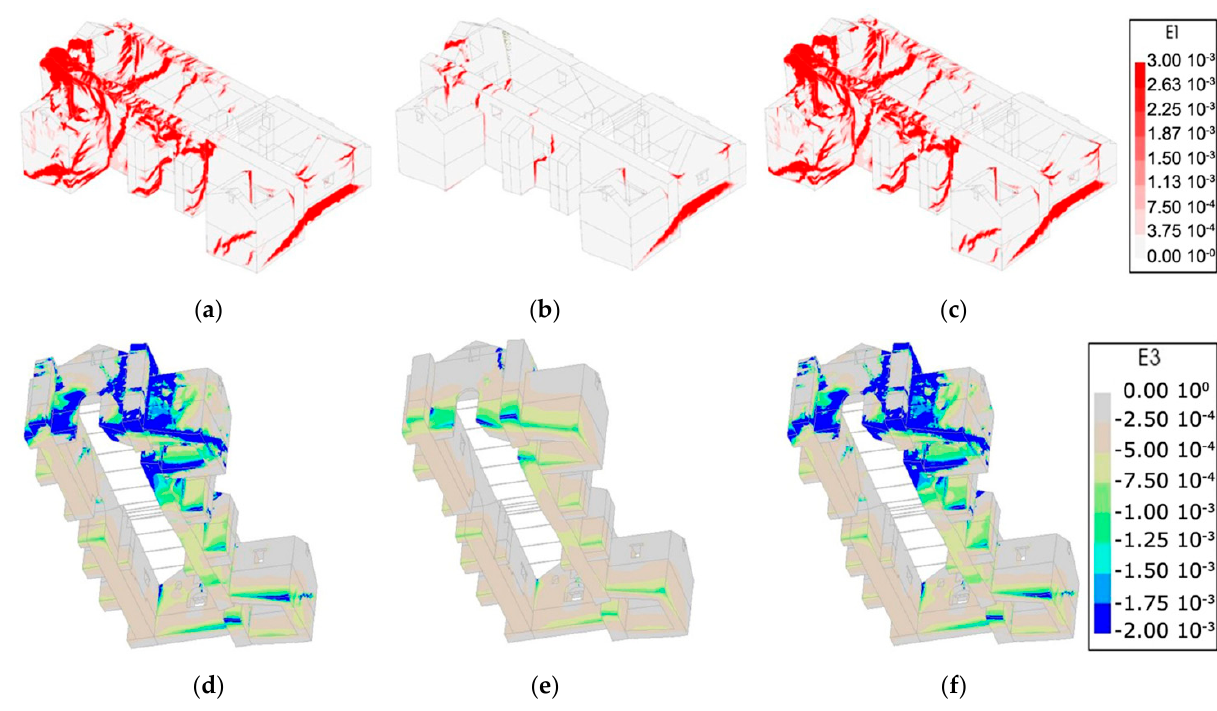
Figure 24. Distribution maximum principal strain in − XX direction at the ultimate stage of ( a ) NTC 2018, ( b ) KADET 2021 and ( c ) ASCE41-13. Distribution minimum principal strain in − XX direction at the ultimate stage of ( d ) NTC 2018, ( e ) KADET 2021 and ( f ) ASCE41-13.